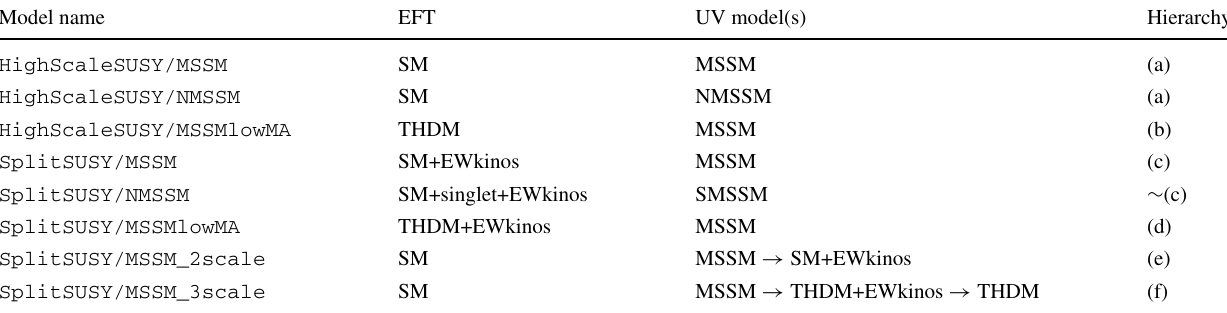
Table 1 The names of the new models which are part of SARAH 4.14.0. The hierarchy in the last column refers to Fig. 7. For the split-NMSSM also a light singlet is present, i.e. the hierarchy is similar to ( c ) , but not identical